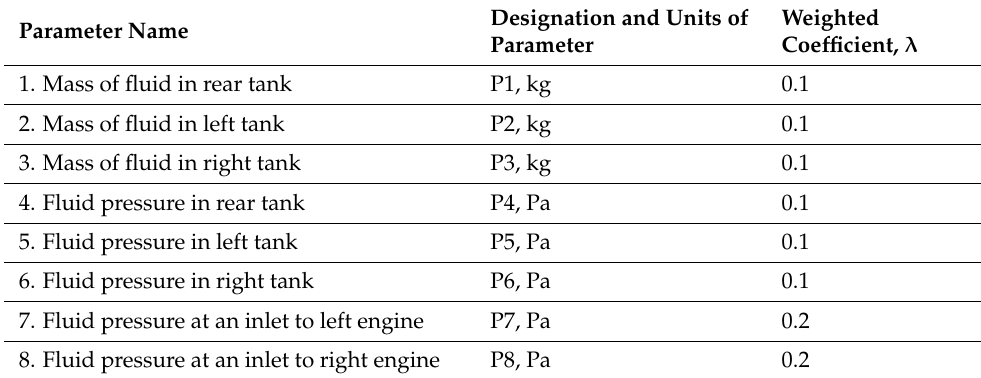
Table 4. Weighted coefficients of objective function.